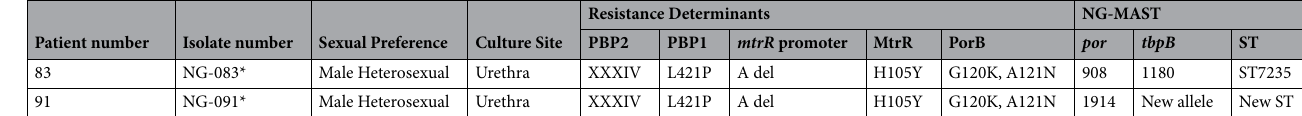
Table 2. Mutations in resistance determinants and NG-MAST sequence types of the N. gonorrhoeae clinical isolates with reduced susceptibility to ceftriaxone (n = 2), Thailand, 2016–2018. MIC minimum inhibitory concentration, WT wild type, New new mosaic pattern, PBP2 penicillin binding protein 2, PBP1 penicillin binding protein 1, mtrR , mtrR promoter, MtrR MtrR repressor, PorB PorB porin, NG-MAST N. gonorrhoeae multi-antigen sequence typing, NG-STAR Neisseria gonorrhoeae Sequence Typing for Antimicrobial Resistance ST, sequence type, A del adenine deletion. * N. gonorrhoeae isolates with reduced susceptibility to